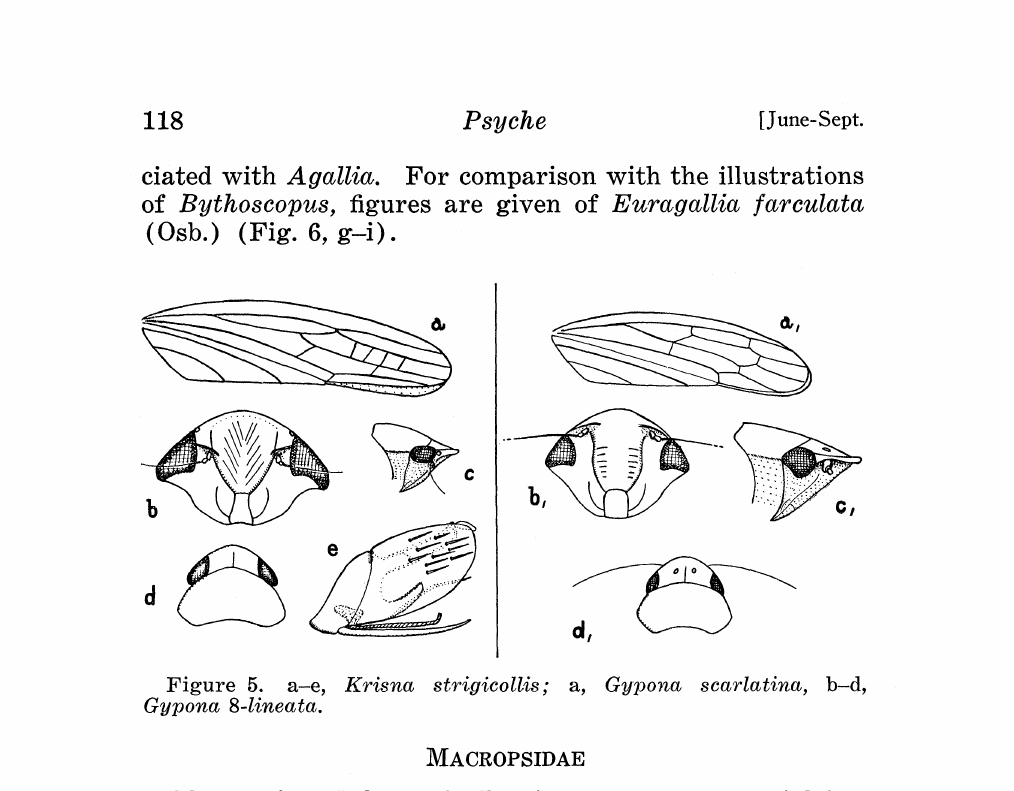
Figure 5. a-e, Krisna strigicollis; a, Gypona scarlatina, b-d, Gypona 8-1ineata.